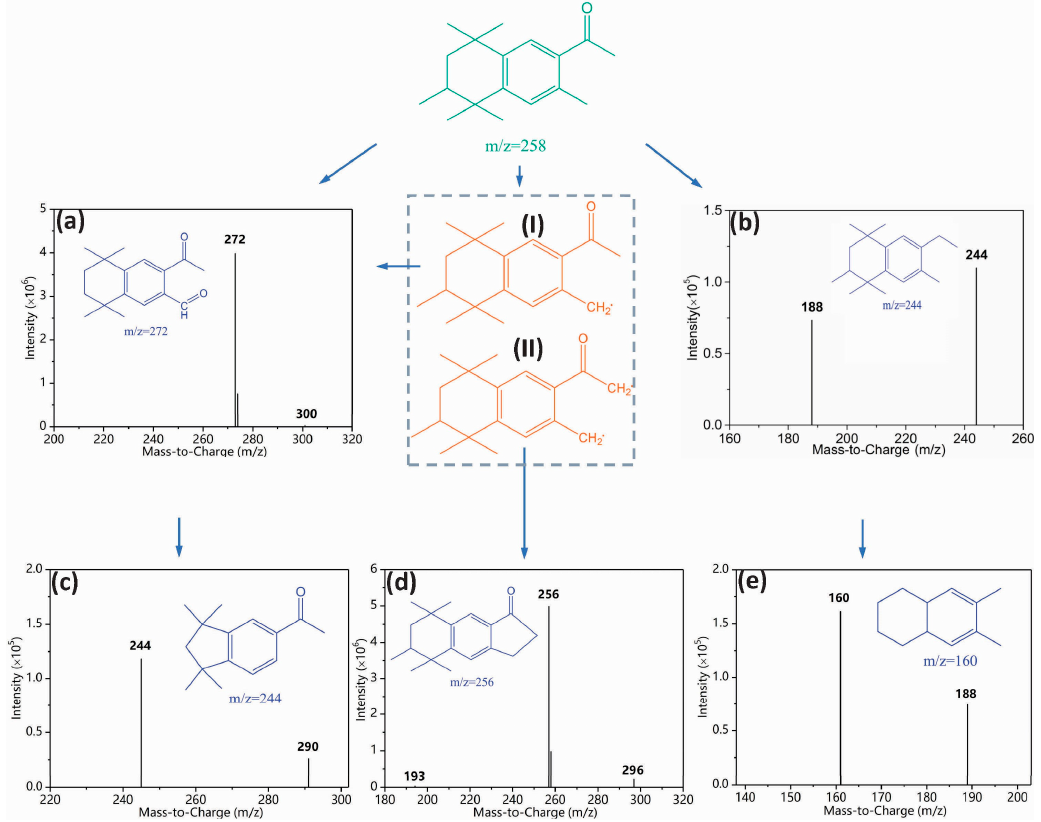
Figure 6. Degradation pathway of AHTN by UV/chlorine process ([AHTN] 0 = 1.0 mg · L − 1 ; pH = 7.0; 25 ± 1 °C; and [FC] 0 = 3.28 mg L − 1 ).